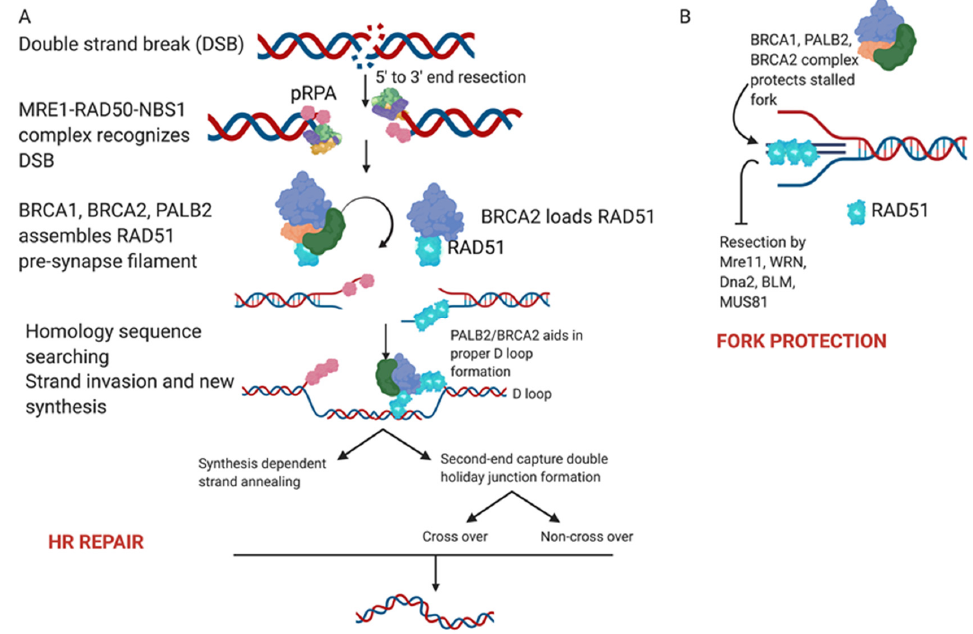
Figure 2. ( A ) Homologous recombination. A DNA double strand break is sensed and recognized by the MRE11-RAD50-NBS1 complex (MRN). The binding of this complex activates ATM kinase that leads to the activation of DNA damage response. Nuclease activity leads to end resection from 5 ′ to 3 ′ that then leads to the formation of single-strand DNA ends coated by phosphorylated RPA (pRPA). The exposed single strand DNA activates ATR’s response to facilitate the repair. This leads to the activation of BRCA/BRCA2/PALB2 complex which prepares RAD51 nucleofilaments for loading on DNA. The RAD51 nucleoprotein filament is loaded by BRCA2/PALB2 on the homology sequence and the RAD51 coated strand along with BRCA2/PALB2 mediates strand invasion and D loop formation. This also releases the MRE11-RAD50-NBS1 complex and the double stranded breaks are restored by branch migration, DNA synthesis and ligation. ( B ) Stalled replication forks are protected by the BRCA1/BRCA2/PALB2 complex with RAD51 loading onto the nascent DNA. This protects from end resection by MRE11 and other proteins to allow fork restart.